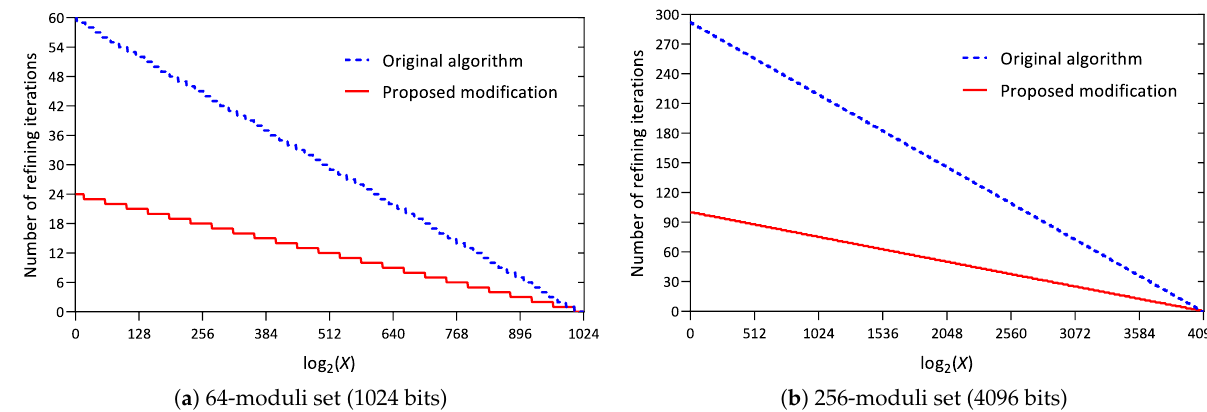
Figure 3. Number of iterations required to compute the interval evaluation of an RNS number with accuracy ε = 10 − 7 in 64- and 256-moduli sets using double precision floating-point